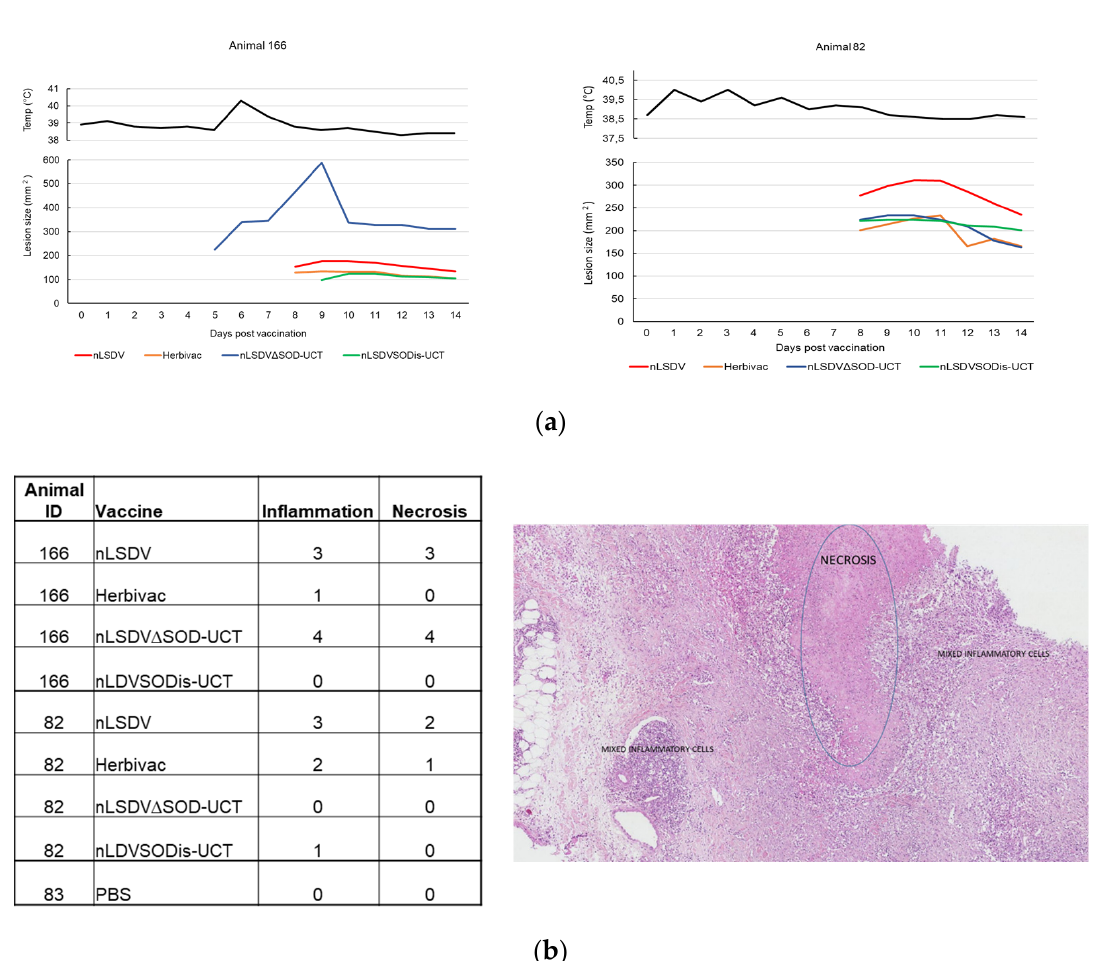
Figure 6. Lesions produced in cattle and histological scoring of biopsies at 14 days post infection. A group of five Friesian cattle (6–12 months old) were each inoculated with the four different LSDV vaccines, nLSDV, Herbivac, nLSDV ∆ SOD-UCT and nLSDVSODis-UCT, at a dose of 10 4 TCID50 for each vaccine and monitored daily for temperature and lesion size. ( a ) Rectal temperatures of animals 166 and 82 and surface area measurements of lesions induced by nLSDV, Herbivac, nLSDV ∆ SOD-UCT and nLSDVSODis-UCT. ( b ) Histological scoring of biopsies taken from the lesions of animals 166 and 82. As a negative control, a biopsy was also taken from the site of PBS inoculation of animal 83. The image shows the typical appearance of regions of necrosis and inflammation.